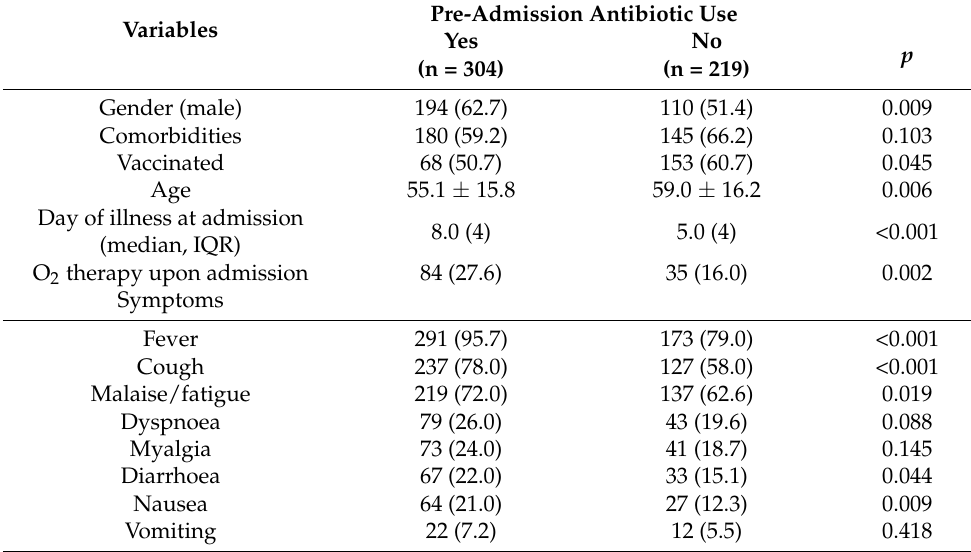
Table 2. Patient characteristics in relation to antibiotic use prior to admission.